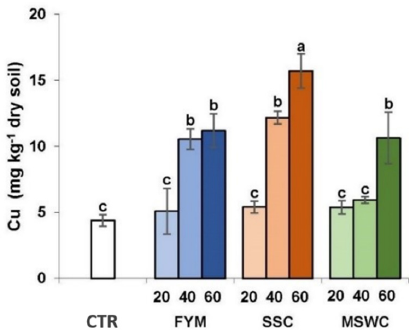
Figure 3. Pseudo-total Cu concentrations in unamended (CTR) soil and soils amended with different doses (20, 40, 60 t ha − 1 ) of farmyard manure (FYM), sewage sludge compost (SSC) or municipal solid waste compost(MSWC).Different letters indicate significant differences between